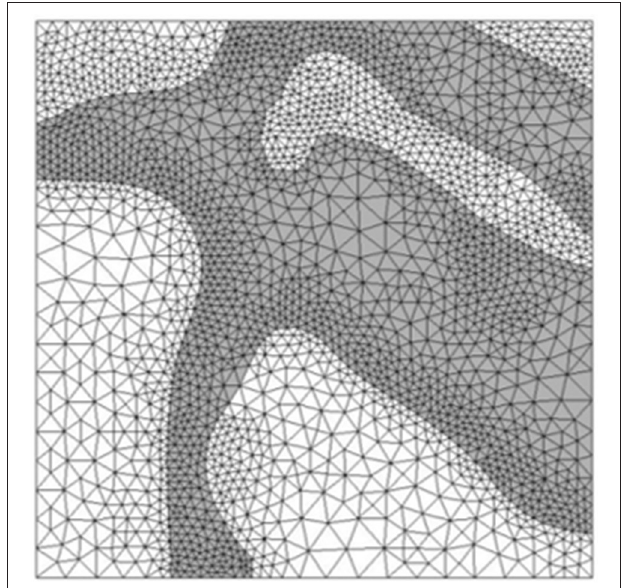
FIGURE 5 | Tetrahedral mesh of heart tissue created in Simpleware. The gray zones represent areas where fluid can flow while white zones represent solid